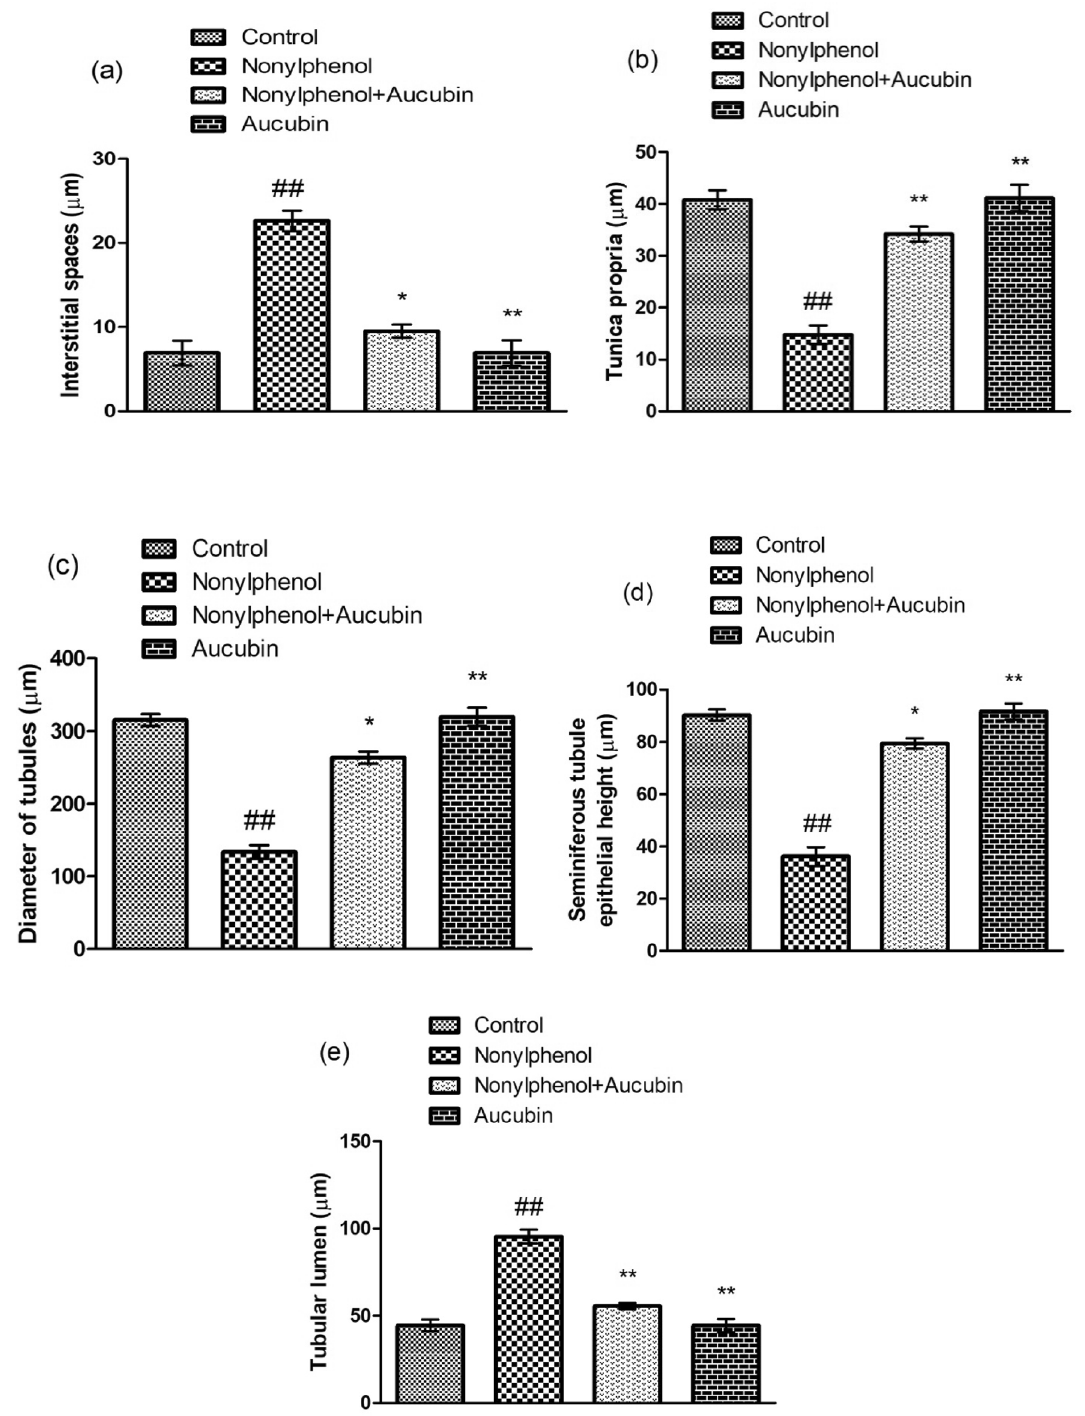
Figure 6. Effect of NP and AU on the testis interstitial spaces ( a ), tunica propria ( b ), diameter of tubules ( c ), seminiferous epithelial height ( d ), and tubular lumen ( e ). Values are expressed as Mean ± SD (12 rats per group). Significant differences displayed as ## P < 0.01 compared to control; * P < 0.05, ** P < 0.05 compared to NP-treated